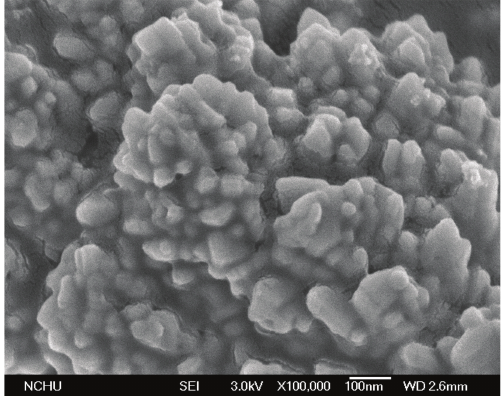
Figure 3: SEM image of TiO 2 prepared by CVD method.